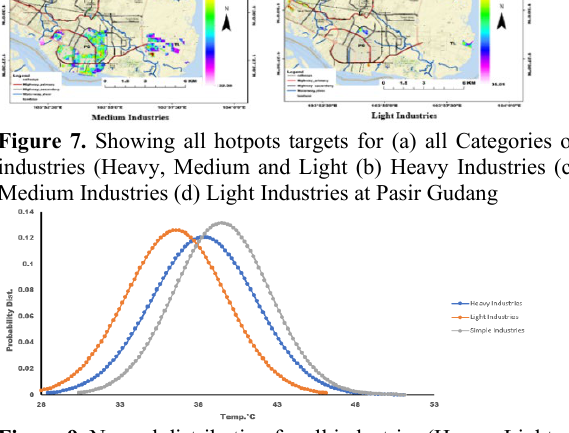
Figure 9. Normal distribution for all industries (Heavy, Light, and Simple).